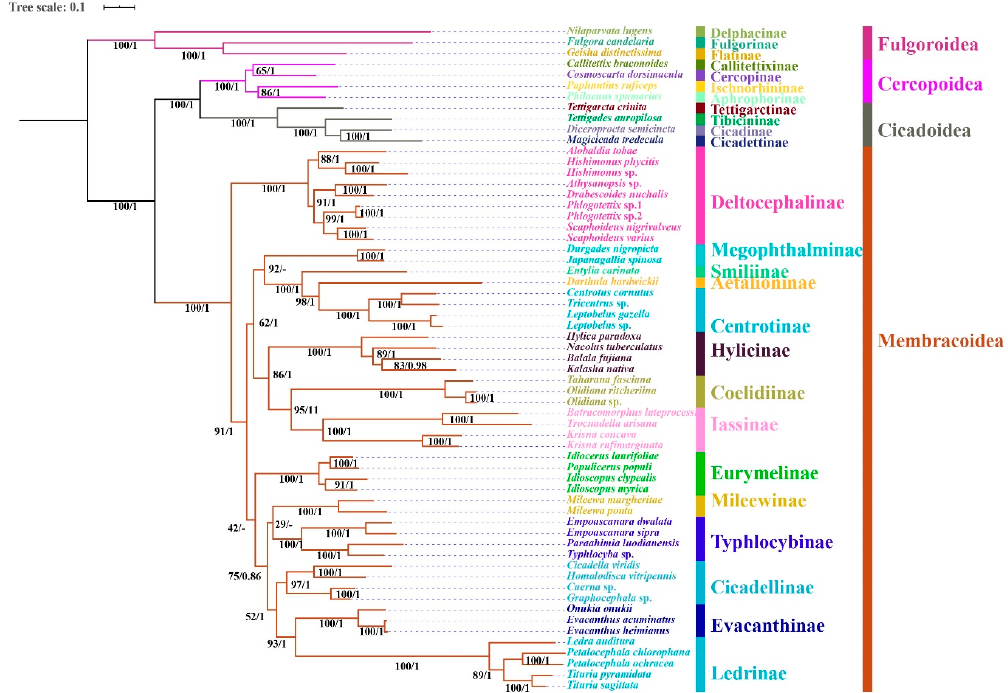
Figure 8. Phylogenetic tree produced by IQtree and MrBayes based on the dataset of AA. Numerals at nodes are Bayesian posterior probabilities (PP) and bootstrap support values (BS), respectively. “-” indicates the clades or species are different.